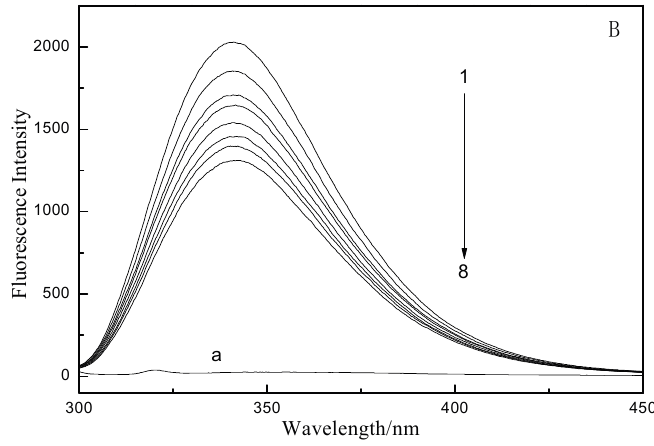
Figure 2. Fluorescence quenching spectra of gallic acid effect on lysozyme ( A ) 298 K; ( B ) 310 K. Curves (1–8): A series 1.0 mL LYS solution (1.0 × 10 − 5 mol/L) were titrated by adding GA stock solutions with a concentrations from top to bottom were 0.0, 0.4, 0.8, 1.0, 1.6, 2.4, 3.2 and 4 × 10 − 5 mol/L. a: The concentration of GA was 1.0 × 10 − 5